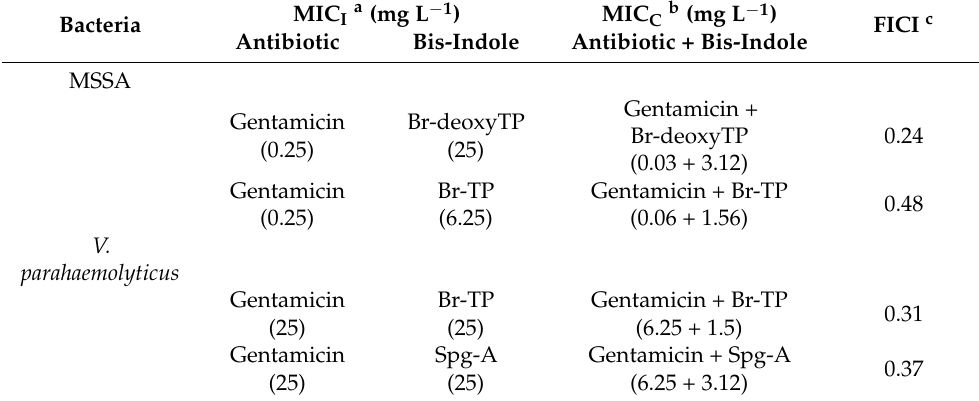
Table 2. Synergy of bis-indoles in combination with